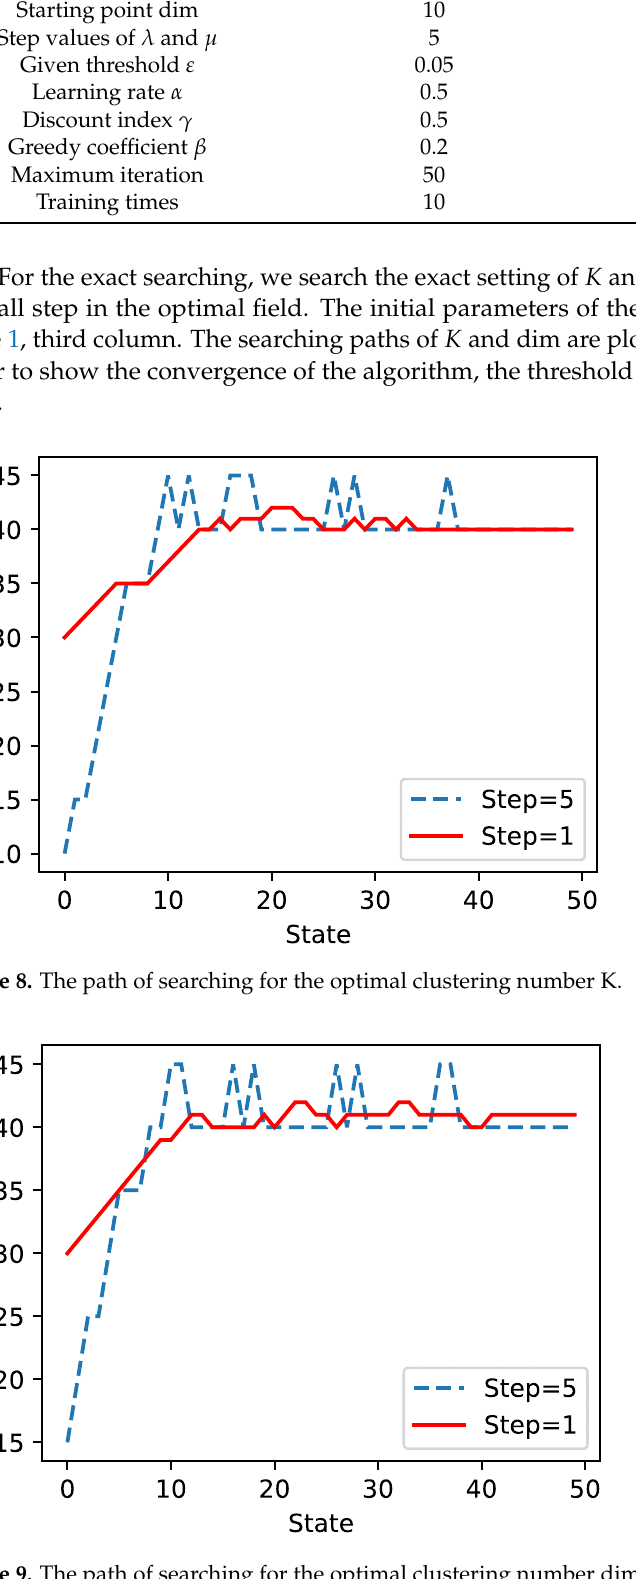
Figure 9. The path of searching for the optimal clustering number dim. We use a combination of rough searching and exact searching to speed up the clus- tering. The final adaptive clustering takes 77.01 s, and each spectral clustering takes about 0.185 s. However, manual clustering parameter adjustment requires multiple compari- sons of all image clustering results, and then multiple adjustments to the parameters. This process requires a lot of time and effort.